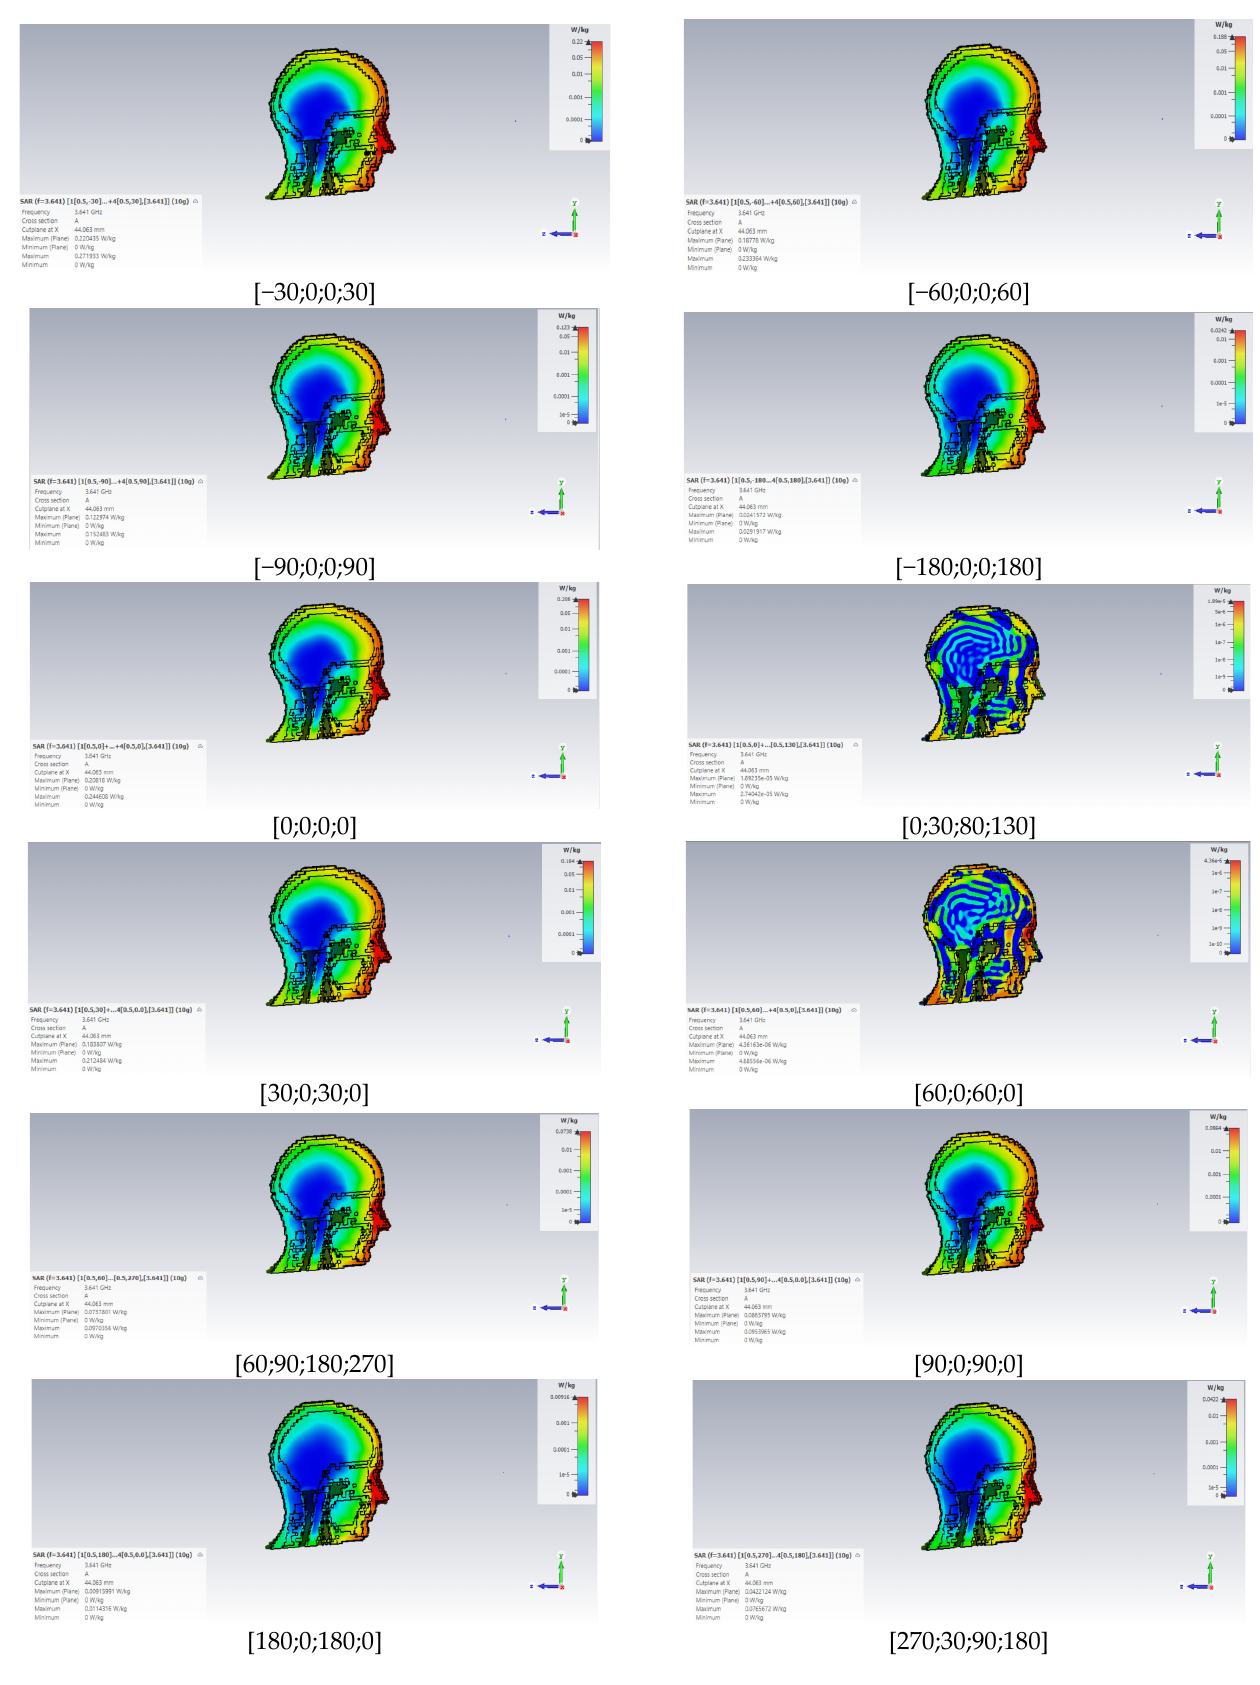
Figure 4. SAR10g (W/kg) distribution in a sagittal plane through the center of the head for the 1 × 4 antenna array as a function of the phase difference (beam steering